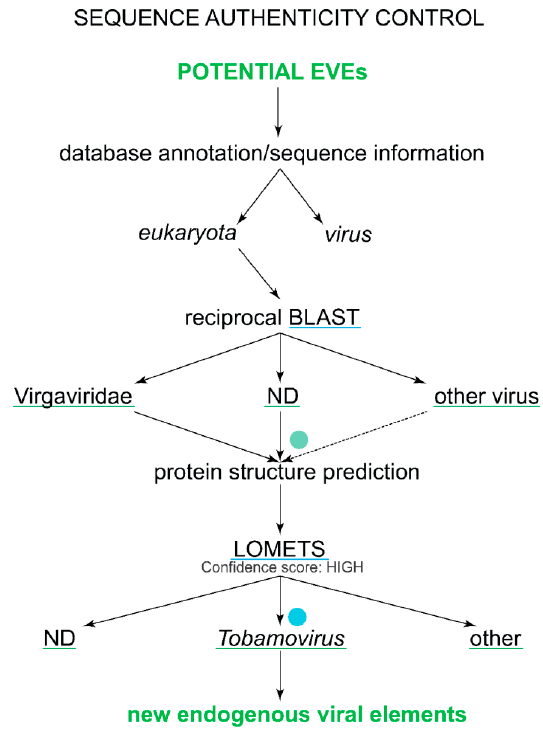
Figure 2. A detailed sequence authenticity control workflow. Each step describes what kind of results can be obtained from each step and what results can be used in further analyses. The programs used in the analyses are underlined with blue line and the results of the analyses are underlined with green line. The green dot shows that we cannot distinguish between viruses and EVEs when only RNA-seq data are available. Similarly, the blue dot shows that, even when protein structure prediction may indicate that the sequence is homologous to a certain virus, this sequence may have a close relative whose structure is not yet solved. However, the protein structure prediction still indicates that the potential EVE sequence most likely belongs to the respective structural superfamily (in terms of the SCOP).